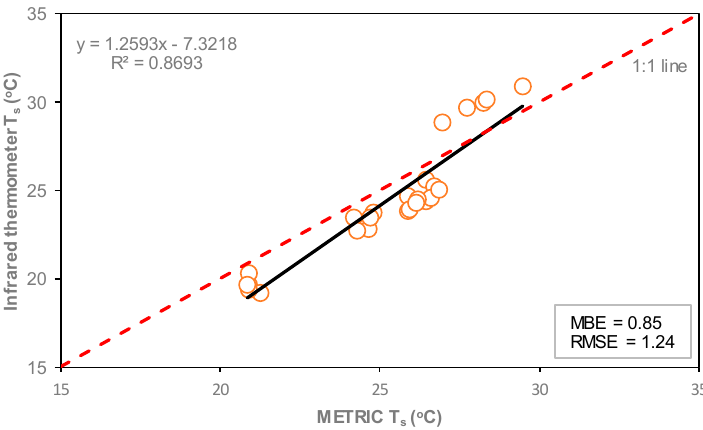
Figure 11. Linear correlation of Ts between the METRIC model and infrared thermometer of corn throughout the 2016 growing season. The red dashed line represents the 1:1 line.